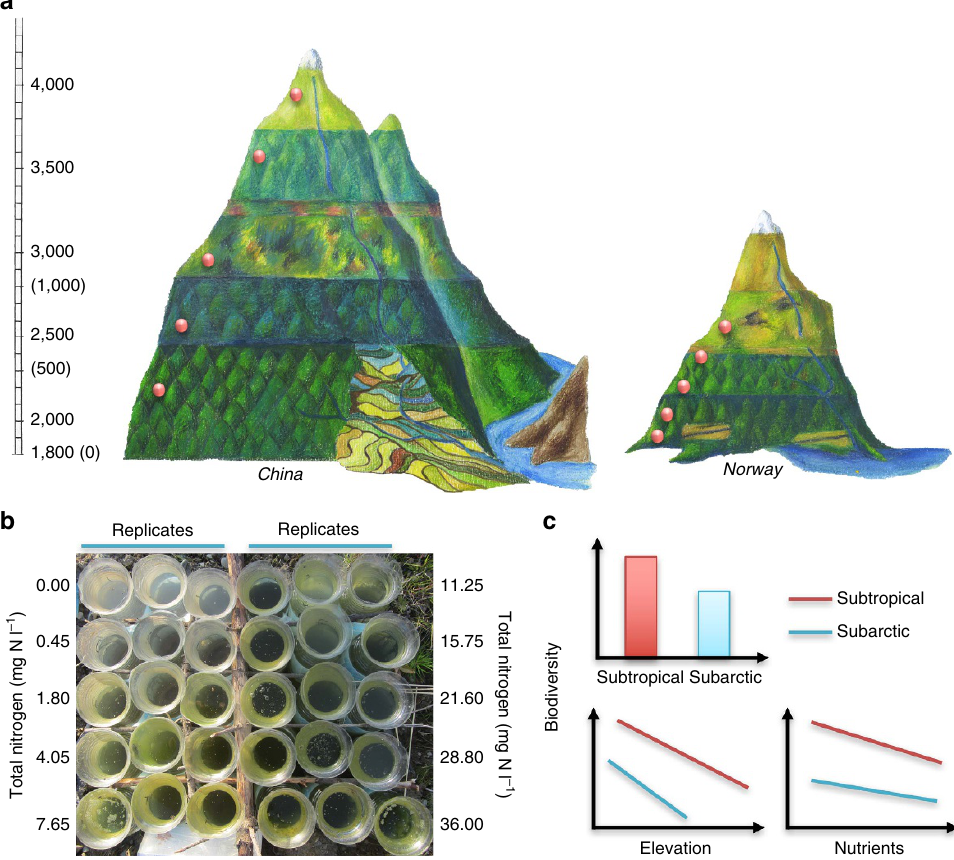
Figure 1 | The manipulation of nutrient enrichment along elevational gradients. The experiments were conducted in parallel in the mountains of the subtropical (that is, China, left panel) and subarctic (that is, Norway, right panel) regions ( a ). The figures of the two mountains were created according to the plant species and climate zones along elevational gradients. Elevations (m a.s.l.) are shown without and with parenthesis for subtropical and subarctic regions, respectively ( a ). Along each mountainside, sterile microcosms with ten nutrient levels and three replicates at each level ( b , field photo) were set up at each of five elevations, indicated by the brown dots ( a ), and were left in the field for 1 month. The nutrient levels were indicated by nitrogen because the ratio between nitrogen and phosphorus was consistent ( b ). Airborne microbes freely colonized the sterile habitats. Nutrient addition promoted the growth of algae, which caused gradual changes in green colour with higher nutrient enrichment ( b ). The bacterial biodiversity was expected to be higher in the subtropics than in the subarctic region ( c , upper panel), and showed predictable patterns along elevation (that is, temperature) and nutrient enrichment ( c , lower panels). The slopes of biodiversity along elevational gradients ( c , left-lower panel) and nutrient enrichment ( c , right-lower panel) were expected to vary between regions, and with nutrient levels and elevations,